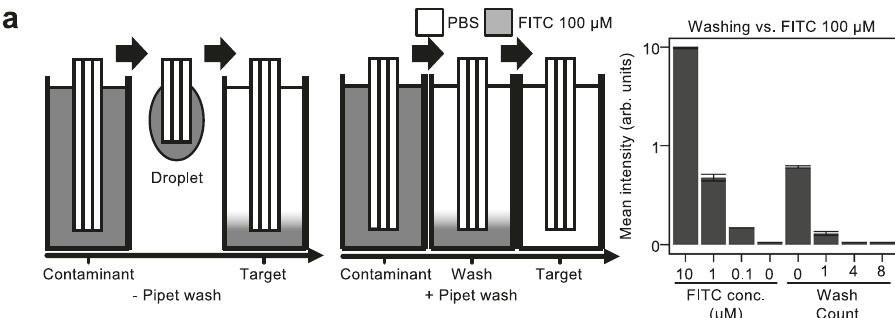
Fig. 4 Washing pipets between samples eliminates contamination. a Cross contamination is eliminated through automated washing procedures. (Left) Pipets carry sample droplets between wells. (Middle) Pipet washing in target medium in unused well reduces contamination. (Right) Pipet washing reduces carry-over contamination. A FITC dilution curve (left) allows inference of FITC concentration from fl uorescence brightness. 0, 1, 4, and 8 wash steps (right) reduce contaminant concentration in the target well to 1%, 0.1%, 0.001%, and 0.0001% of the contaminant source well concentration (100 µ M, n = 24 samples). Box plot features, from top to bottom, represent maximum, 3rd quartile, median, 1st quartile, and minimum